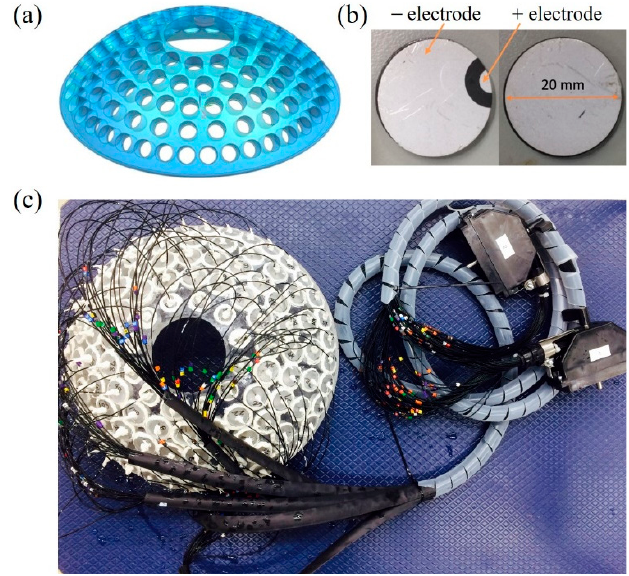
Figure 3. Configuration of the phased-array transducer. ( a , b ) show the schematic drawing of the helmet housing and a flat PZT-4 disc, respectively. The picture of the home-made phased-array prototype is shown in ( c ).